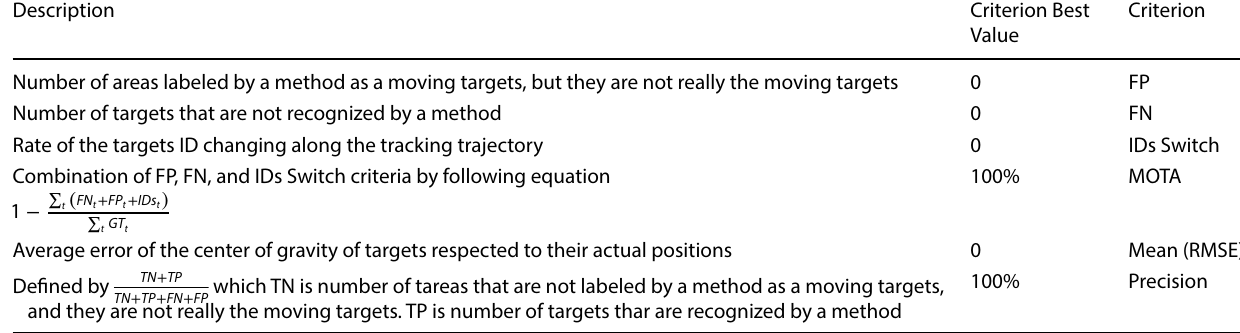
Table 7 Performance comparison of the proposed method with a number of similar methods using S2.L1